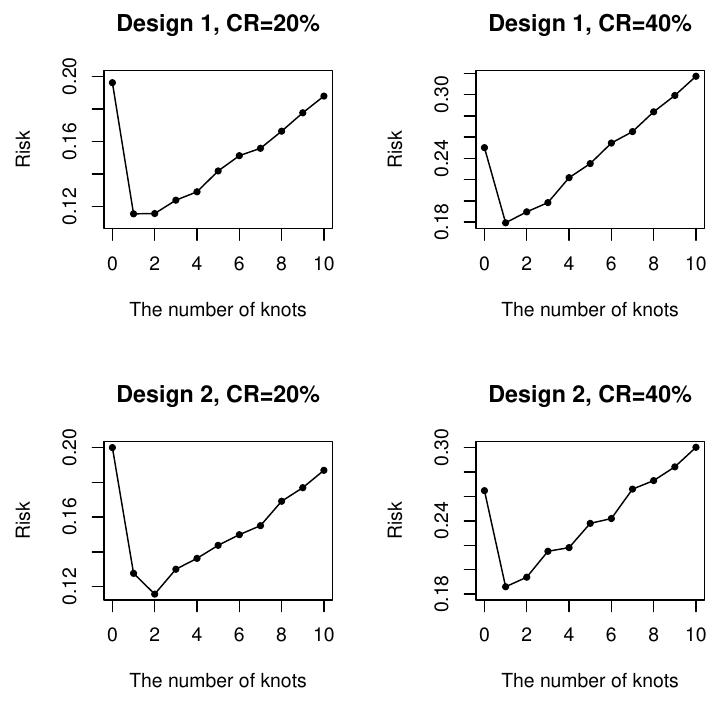
Figure 1. The curves of the mean of risk with the number of knots over 500